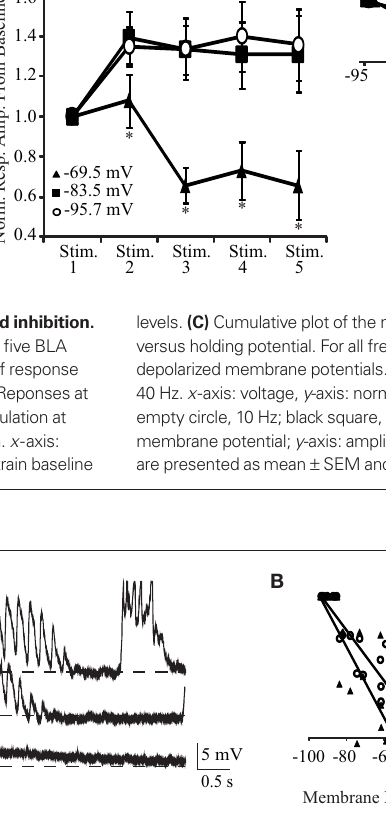
FIgure 7 | reponses to tetanic stimulation. (A) Individual traces of a representative neuron’s response to 100 Hz stimulation of BLA at different holding potentials. The duration of the train (400 ms) is indicated by the black rectangle. Note the slow decay following stimulation offset and the rebound depolarization. (B) Population plot of reversal potentials showing that the peak